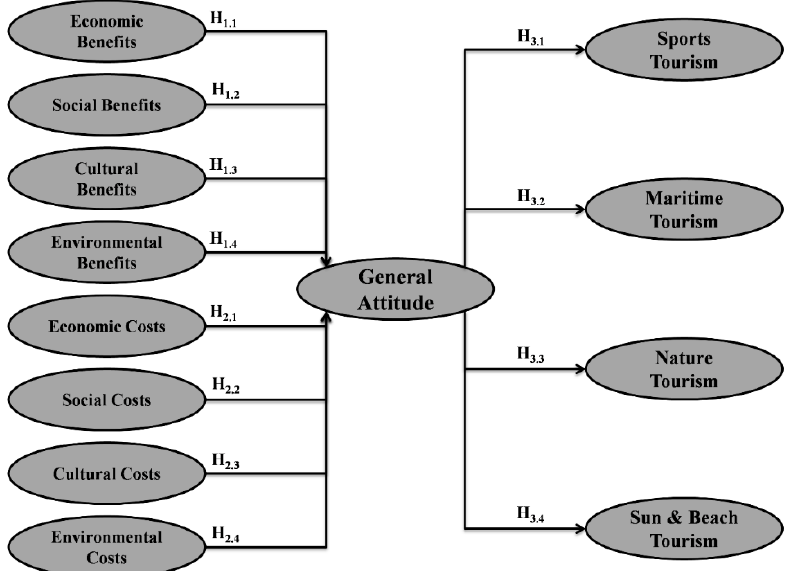
Figure 1. Proposed structural